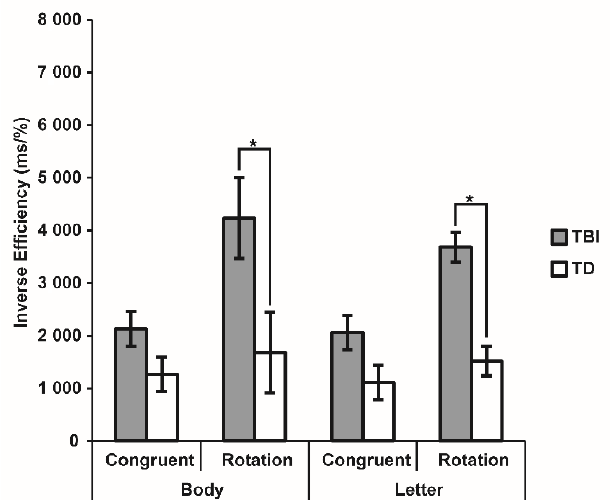
Figure 4. Inverse Effect (IE) for each condition of the Visuospatial Imagery Paradigm for the two groups. Bars indicate Standard Error of the Mean of measurements in 64 Body and 64 Letter trials for 31 TBI and 31 TD children. Dotted black lines show between-groups comparisons, with asterisks indicating significant p < 0.05.